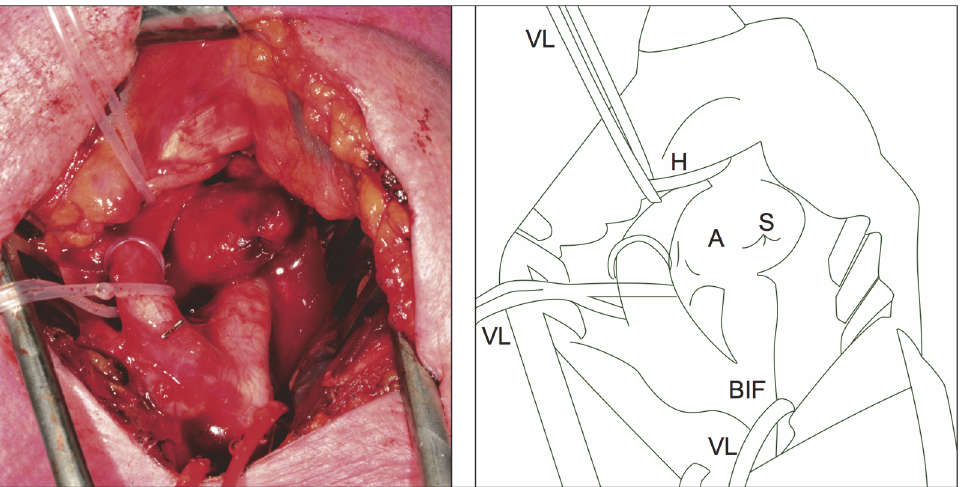
Fig 1. In vivo aneurysm. Aneurysm of a left saccular carotid artery visible between the internal carotid artery (ICA) and the external carotid artery (ECA) and originating from a dorsal loop in the ICA. The common carotid artery is ligatured in red, the ECA is identified with transparent ligatures. A, aneurysm of